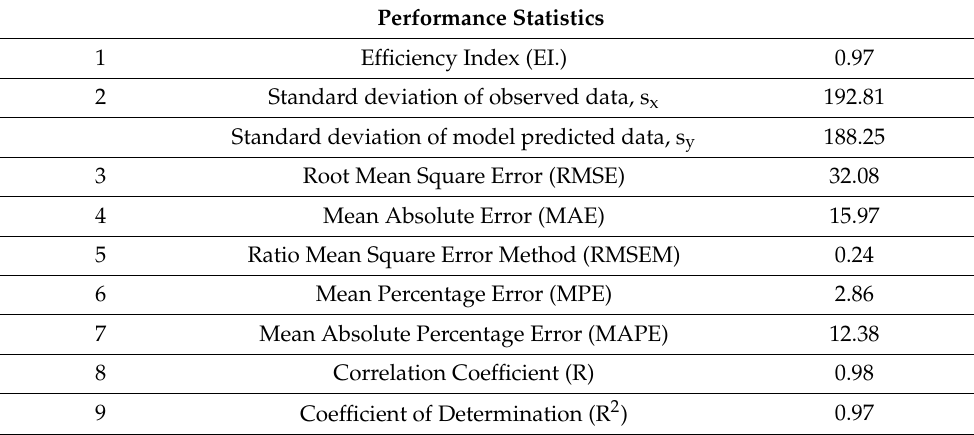
Table 2. Statistical performance of the overall model outcomes compared to the field observations.